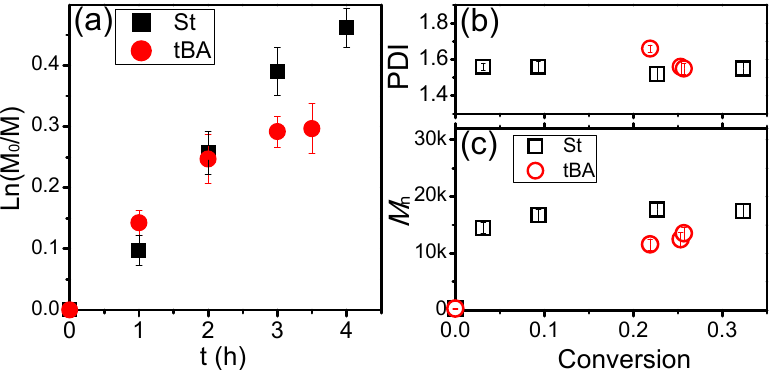
Figure 1. ESCPs of St and tBA: ( a ) Ln vs. t and ( b , c ) M n , PDI vs. conversion plots at 80 °C (M/AIBN/PBBN = 400/1/1; [M] 0 = 4.0 M).